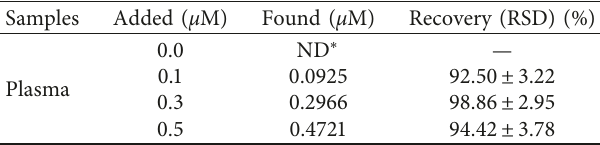
Table 4: Determination of DOX in human plasma samples ( n � 6).